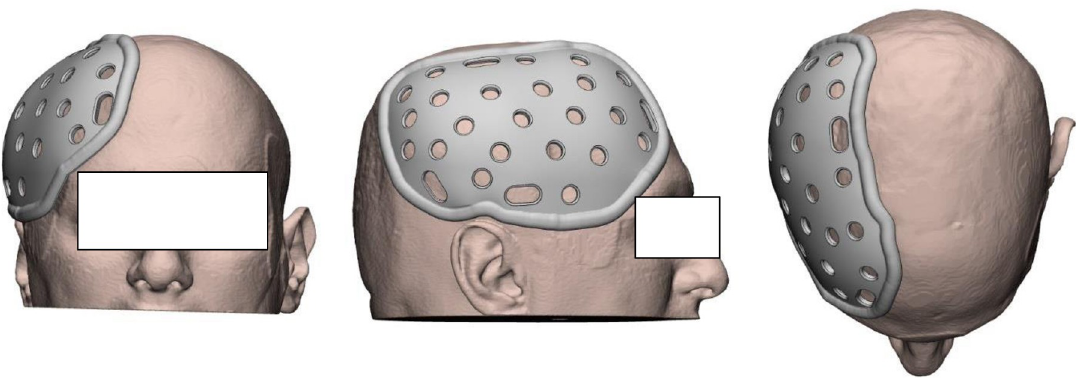
Fig 1. 3-Dimensional rendering of the head protection prototype device (HPPD). The rendering excludes the cranium model and the elastic fabric bands. Grey represents HPPD. Beige represents cutaneous model. (Image courtesy of AuMed, Singapore). Anterior (left image), Right lateral (centre image), Top (right